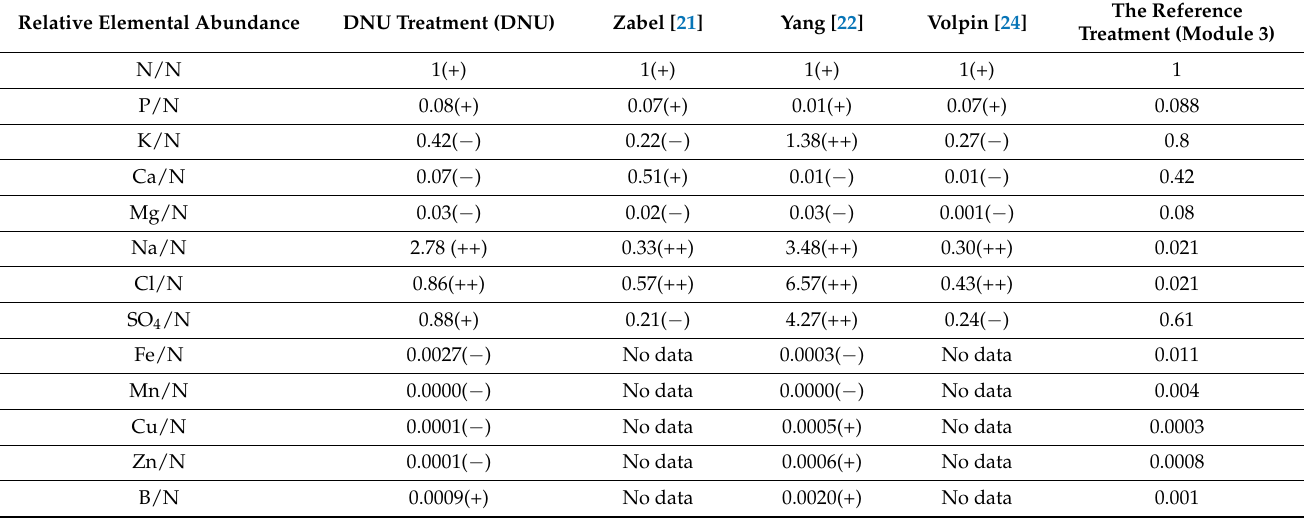
Table 6. Nutrient composition in nutrient solution—abundance (“ − “—element in insufficient concentration, “+”—element in sufficient concentration, “++”—excess of given